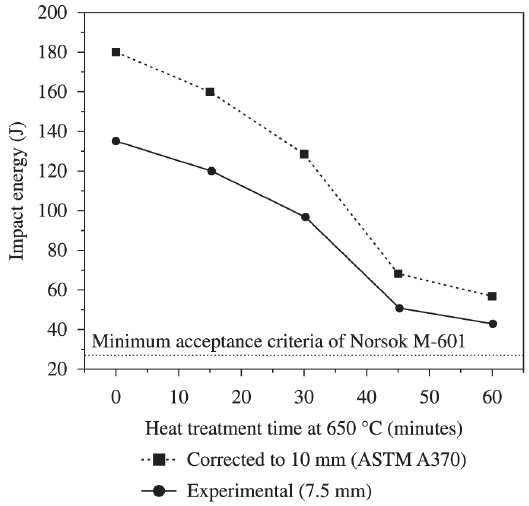
Figure 6. Variation of impact energy with time of PWHT (650 °C).